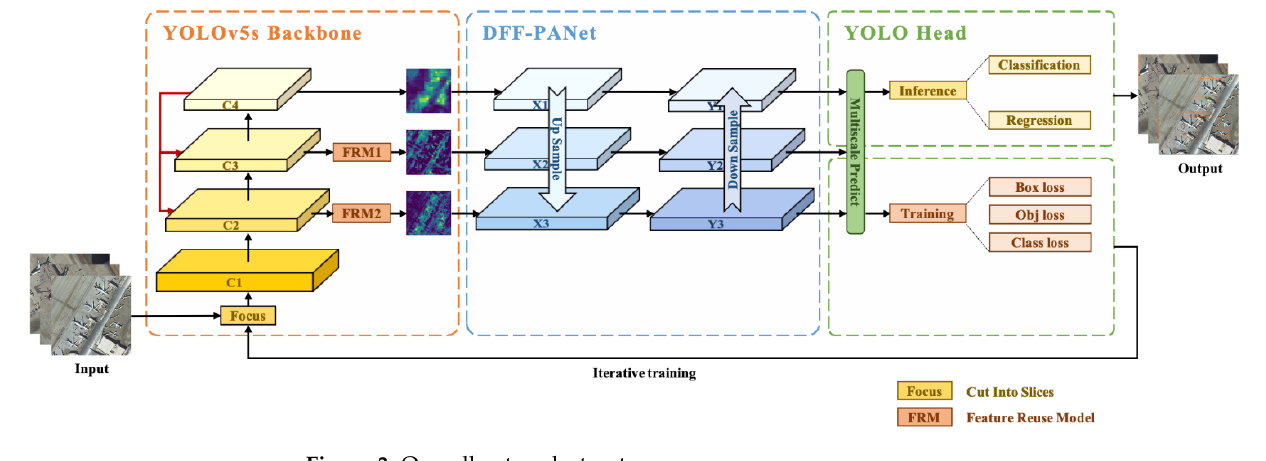
Figure 3. Overall network structure.